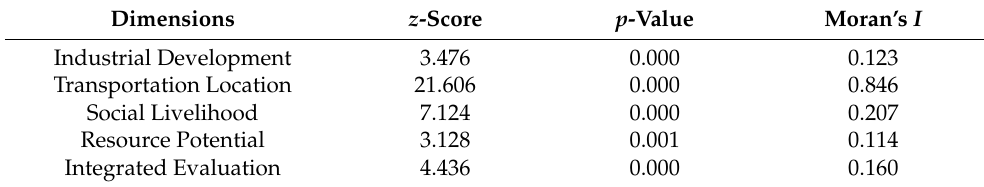
Table 4. Results of Global Moran’s I